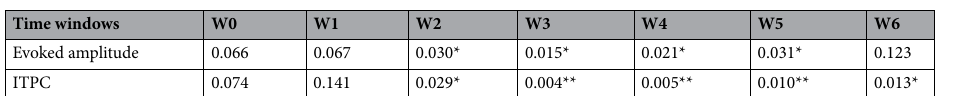
Table 1. p values of planned t-tests of evoked oscillation amplitude and ITPC at the α-band. The frequency of interest is 10 Hz. The electrode of interest is the average of O2 and PO4 (near the stimulation loci; see Fig. 1C). The planned contrasts are between rhythmic and arrhythmic-active stimulation conditions in the seven pre- defined time windows, including the periods before (W0), during (W1–W3), and after (W4–W6) stimulation. The contrasts are significant starting from W2 until W5 or W6. *p < 0.05. **p < 0.01.